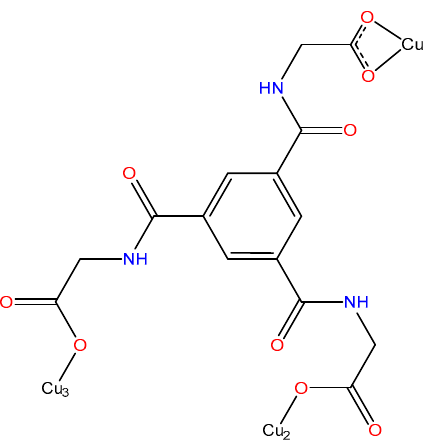
Figure 3. Coordination mode of the (L 1 ) 3 − organic ligand found in 1 .